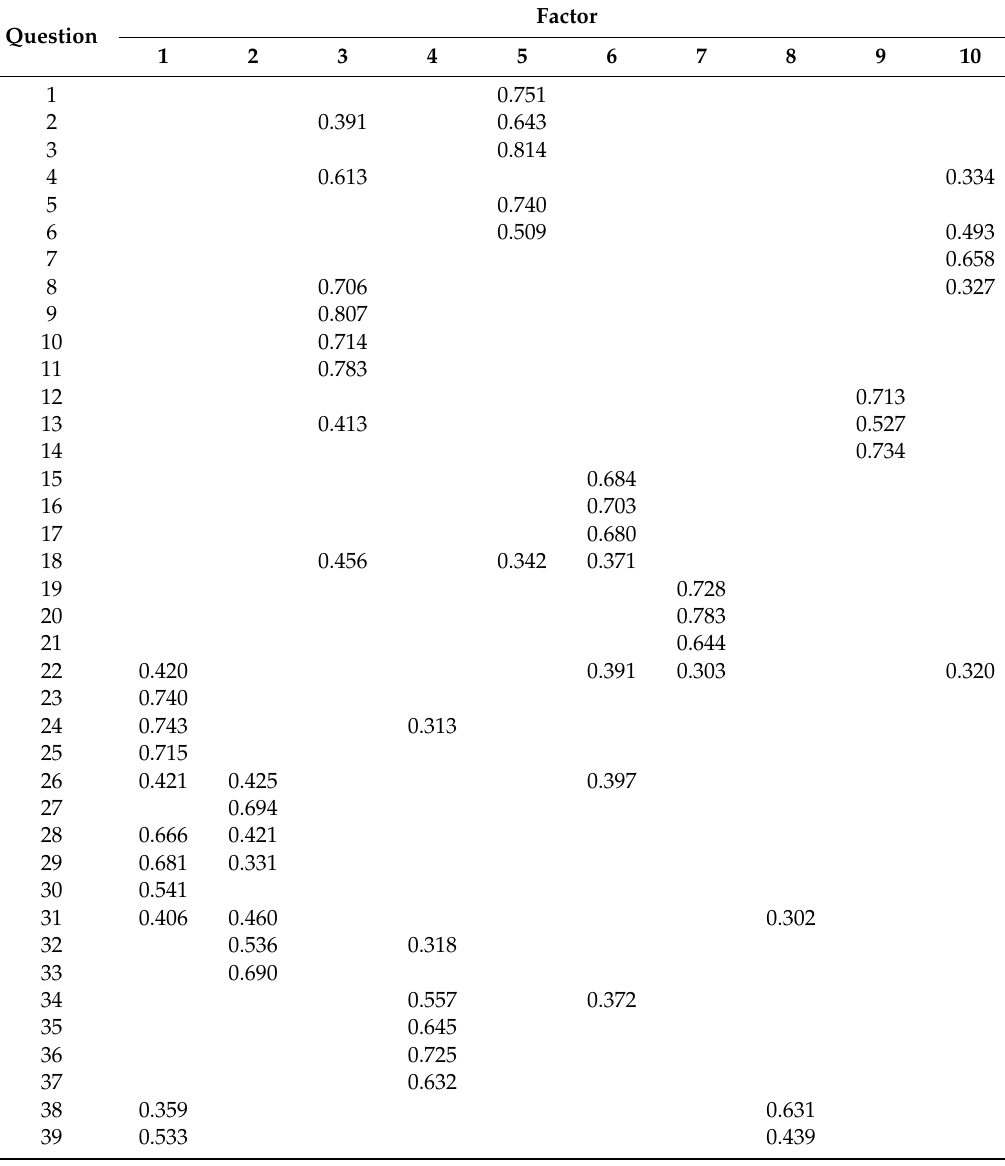
Table 3. Principal component